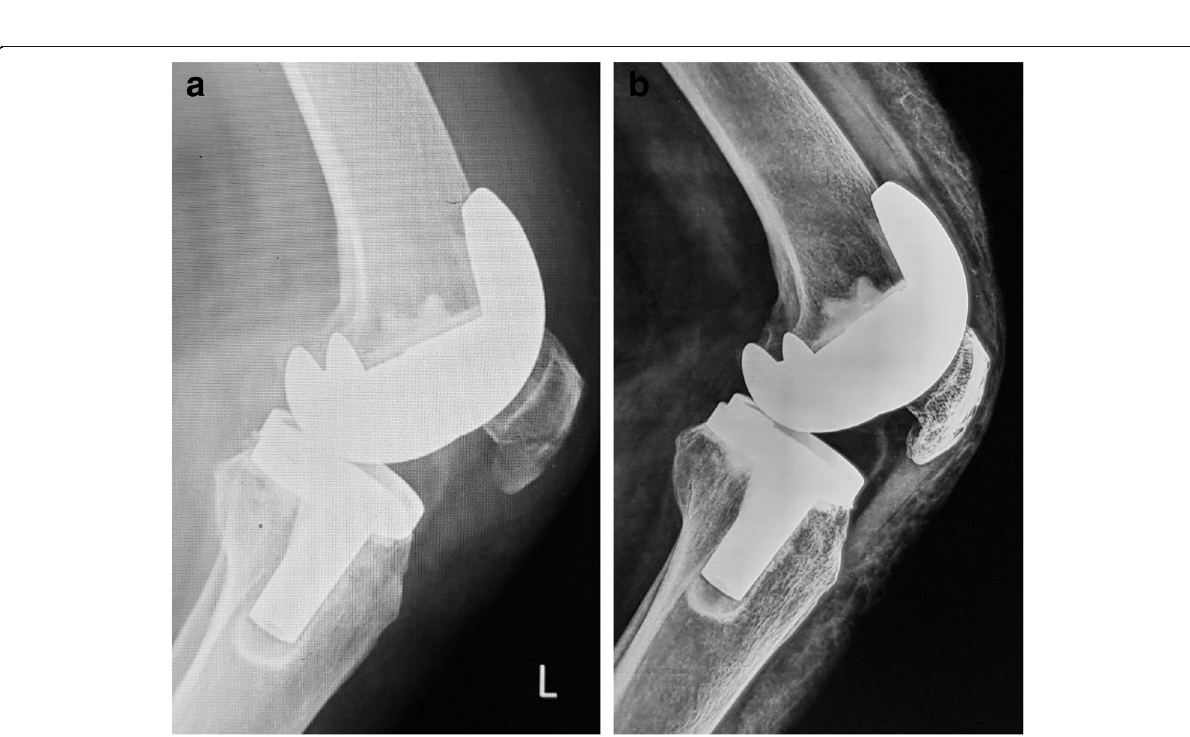
Fig. 4 A 64-year-old female who suffered a PPPF in her left knee (case 4 in Table 1). a Preoperative lateral X-ray shows a posterior stabilized system (Depuy) and minimally displaced fracture. b The fracture is managed conservatively with good union one year later